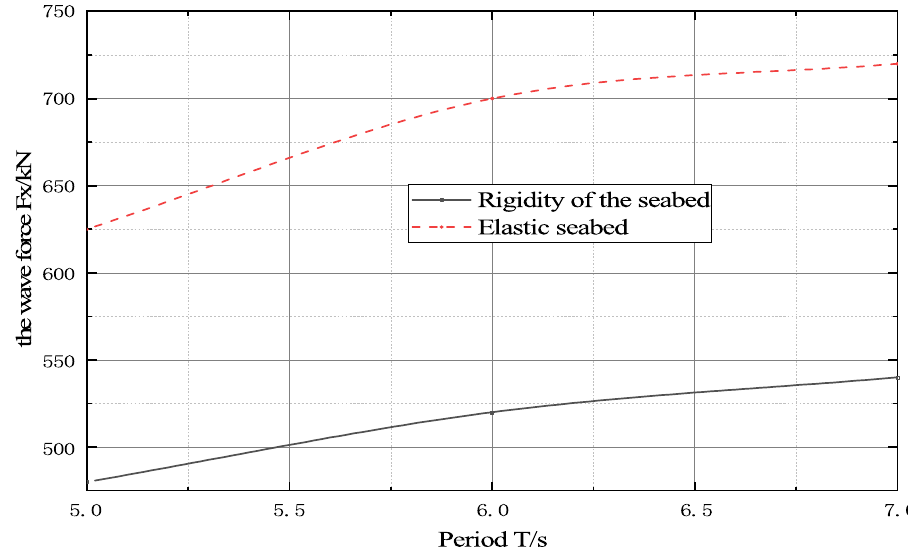
Fig. 5 Under different period T conditions F change xmax